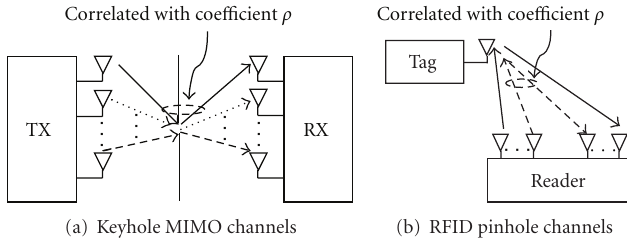
Figure 1: The scenarios of keyhole MIMO channels and RFID pinhole channels.